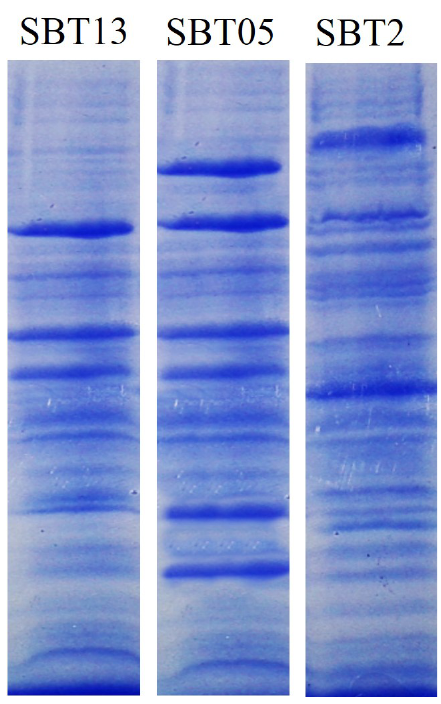
Fig. 2. Whole-cell protein fingerprints of the major occurring endophytic electrotypes isolated from the sugar beet leaves.